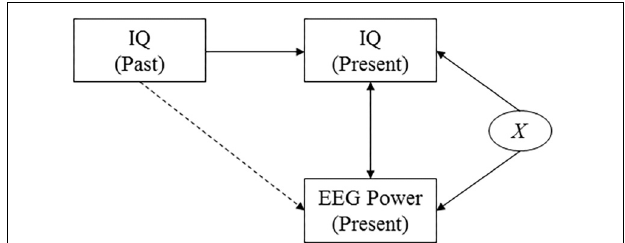
FIGURE 3 | Causal diagram. The diagram shows the assumed causal relationships between cognitive performance at two points in time, EEG power, and a confounding variable. This diagram highlights the effect of an unobserved confounding variable, X , that affects both presently measured intelligence scores and presently measured EEG power (for example measurement-day related factors such as subject tiredness). It reveals that by investigating the correlation between past intelligence and presently measured EEG power, the effect of the confounding variable is accounted